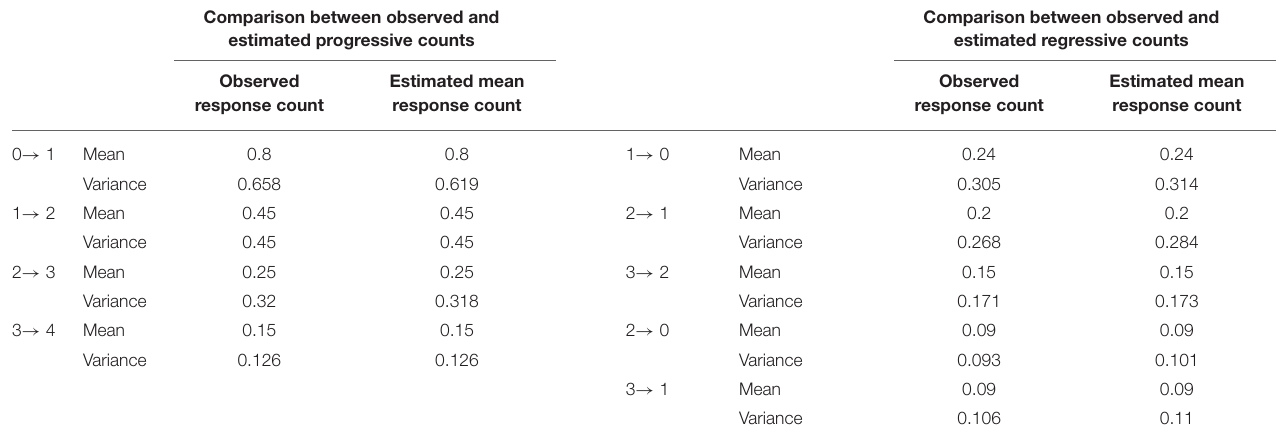
Comparison between observed and estimated regressive counts